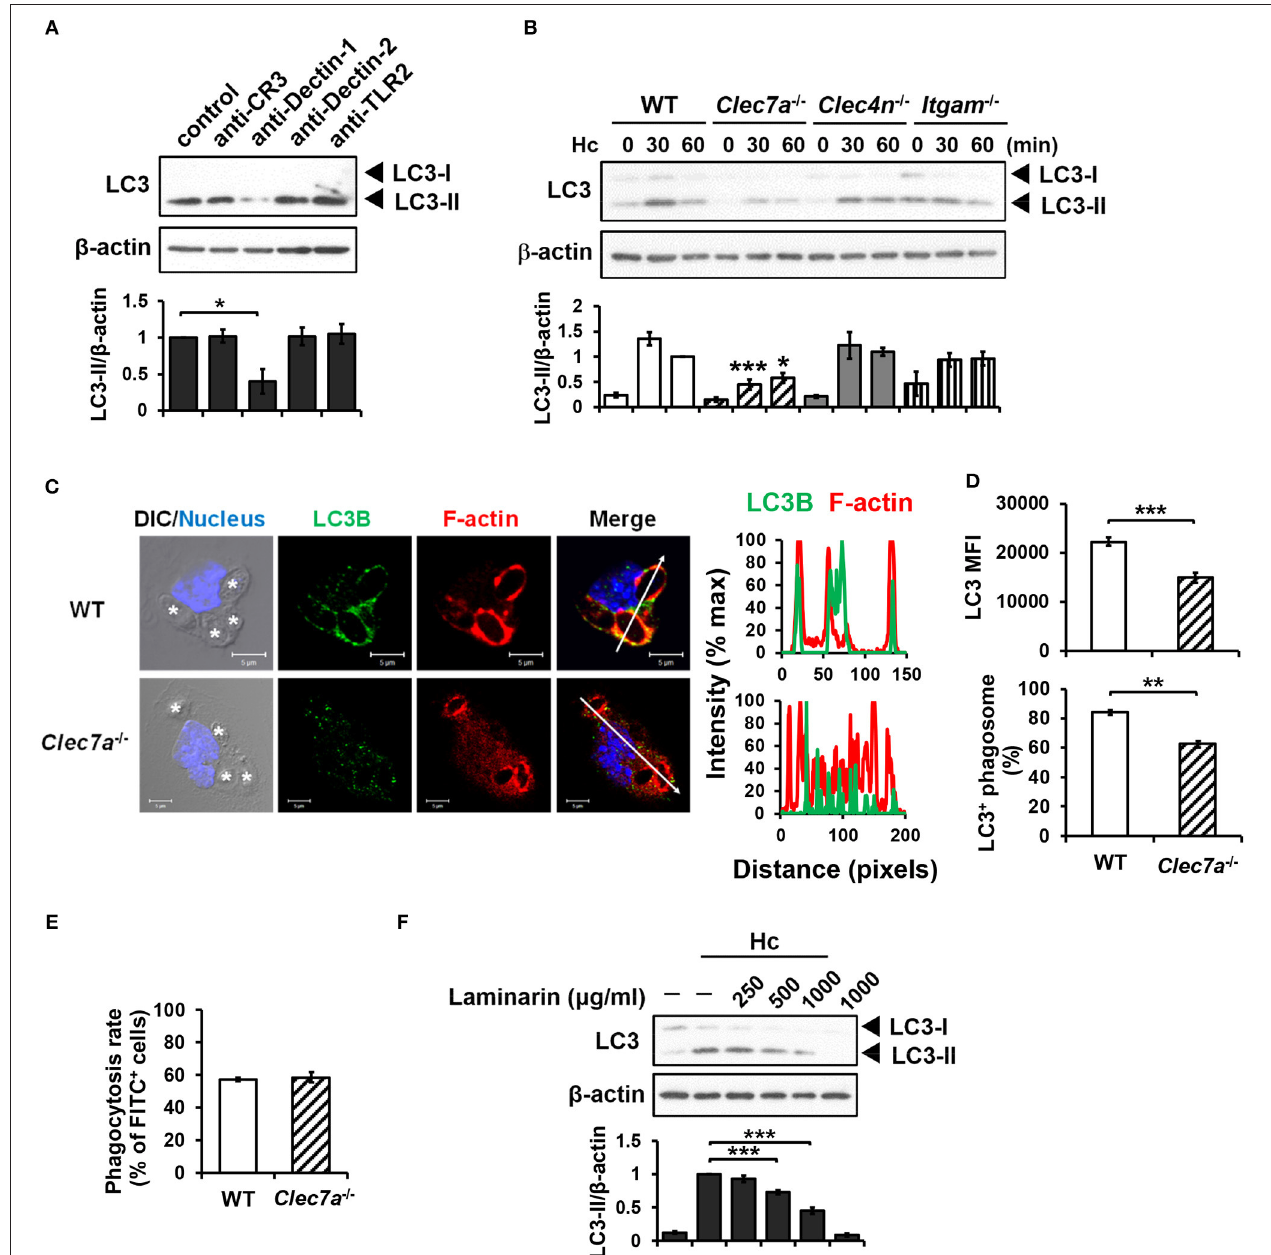
FIGURE 2 | Dectin-1-mediated recognition is crucial for H. capsulatum- induced LC3-II formation. (A,F) Macrophages from WT mice were treated with blocking antibodies against CR3, Dectin-1, Dectin-2, or TLR2 (10 µ g/ml each) (A) or laminarin at indicated concentrations (F) for 1h prior to stimulation with H. capsulatum (MOI = 5) for 1h. Cell lysates were extracted and analyzed by Western blotting. (B) Macrophages from WT, Clec7a − / − , Clec4n − / − , and Itgam − / − mice were stimulated with or without (0min) H. capsulatum (MOI = 5) for 30 and 60min. Cell lysates were subjected to Western blotting. Data shown in the lower panel are relative intensity of LC3-II normalized against the corresponding β -actin, mean ± SEM are shown [ n = 3 for (A,B) , n = 5 for (F) ]. (C,D) Macrophages from WT and Clec7a − / − mice were stimulated with H. capsulatum (MOI = 5) for 1h. Cells were fixed and stained for LC3B (green), F-actin (red), and the nucleus compartment (blue). Cells were viewed under confocal microscope. Asterisks in the DIC/Nucleus image point to H. capsulatum yeasts. The intensity of different fluorochromes along the white arrow in the merged image is shown as the histogram on the right. The mean fluorescence intensity (MFI) of LC3 in cells engulfing H. capsulatum was quantified. Phagosomes in each cell were counted and the percentages of LC3 + phagosome are shown. Bars represent the mean ± SEM of 3 independent experiments. (E) Macrophages from WT and Clec7a − / − mice were allowed to phagocytose FITC-labeled H. capsulatum (MOI = 10) for 1h. Percentages of cells taking up H. capsulatum were analyzed by flow cytometry. Mean ± SEM are shown ( n = 4). * p ≤ 0.05, ** p ≤ 0.01, *** p ≤ 0.001 [ANOVA with Bonferroni’s multiple comparisons post-hoc test (A,B,F) ; 2-tailed t -test (D,E) ].